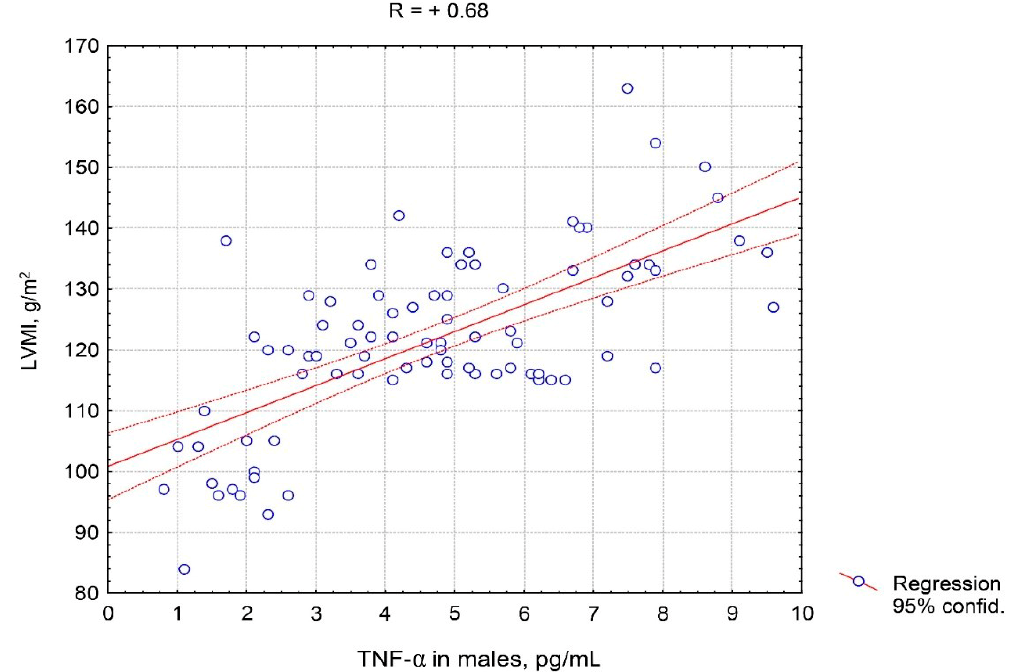
Figure 6. Correlative association of tumor necrosis factor alpha serum levels and left ventricular myocardial mass index in males with hypertension complicated by CHF with preserved left ventricular ejection fraction. Abbreviations: TNF- α : tumor necrosis factor alpha, LVMI: left ventricular myocardial mass index.